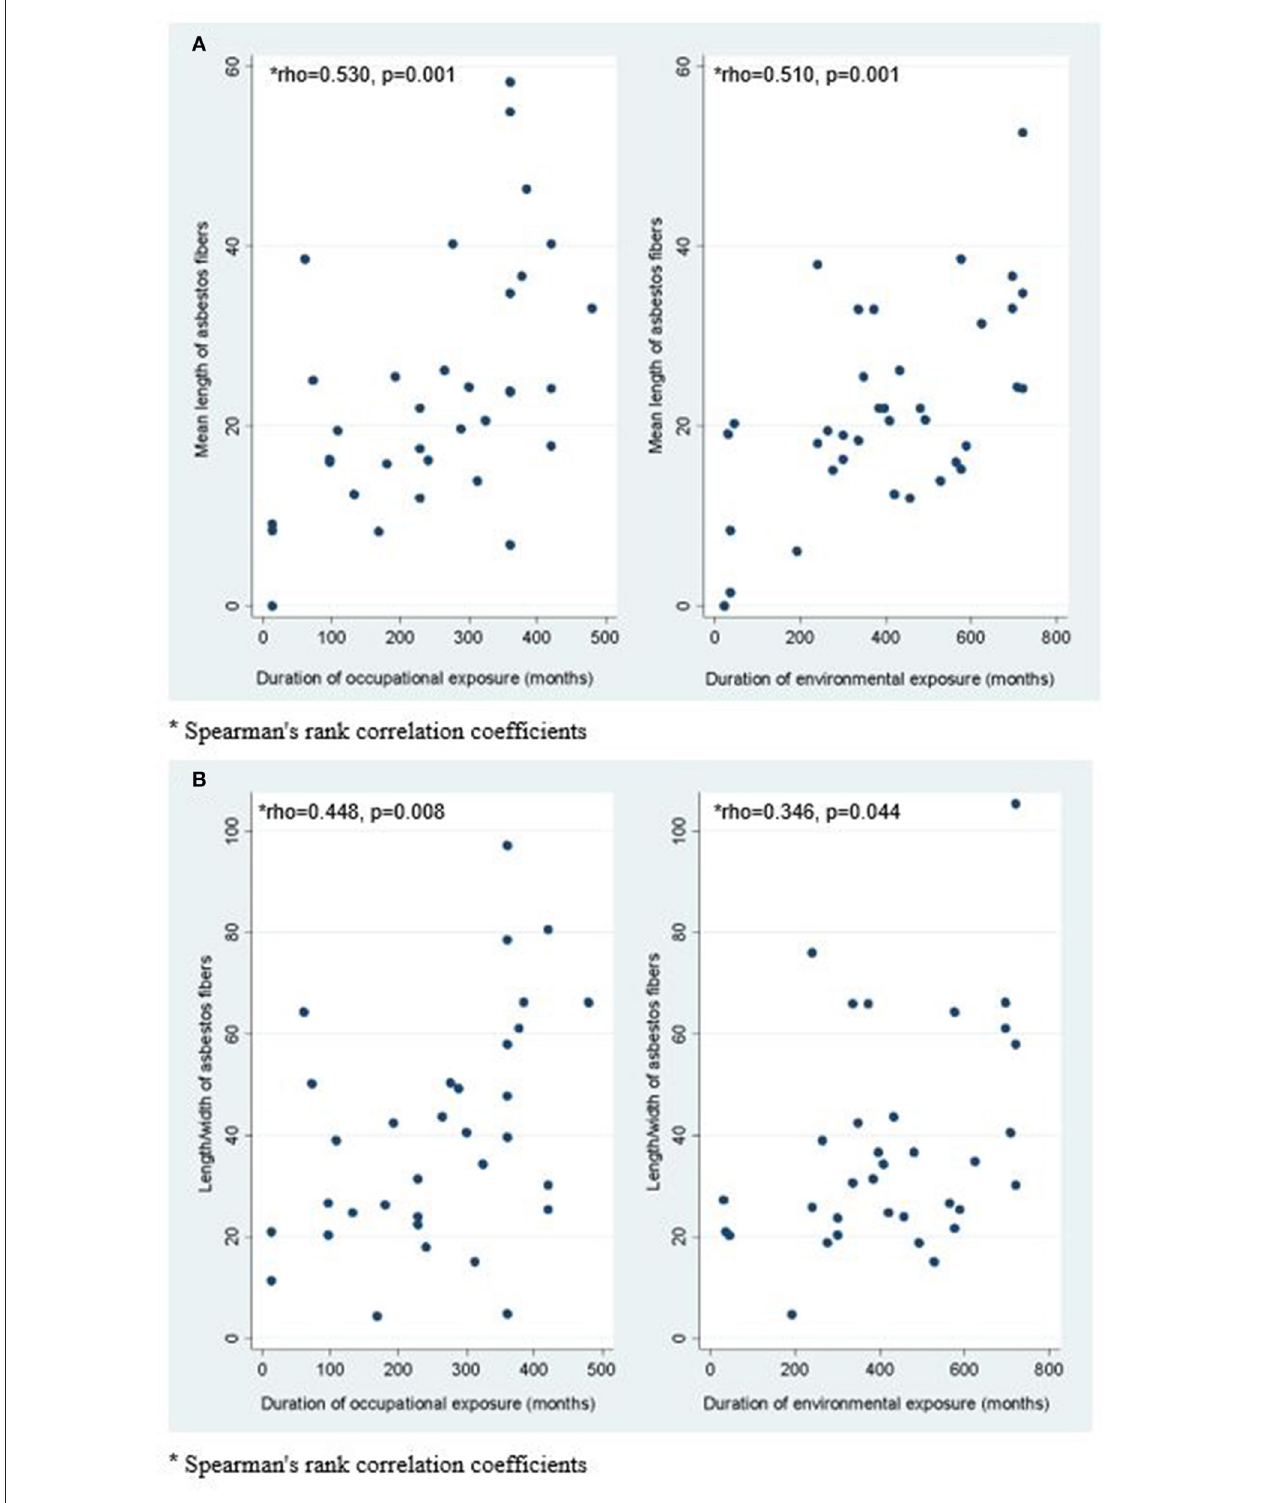
FIGURE 1 | Correlation between duration of occupational and environmental exposure and mean length of asbestos fibers (A) ; Correlation between duration of occupational and environmental exposure and length/width ratio of asbestos fibers (B) .